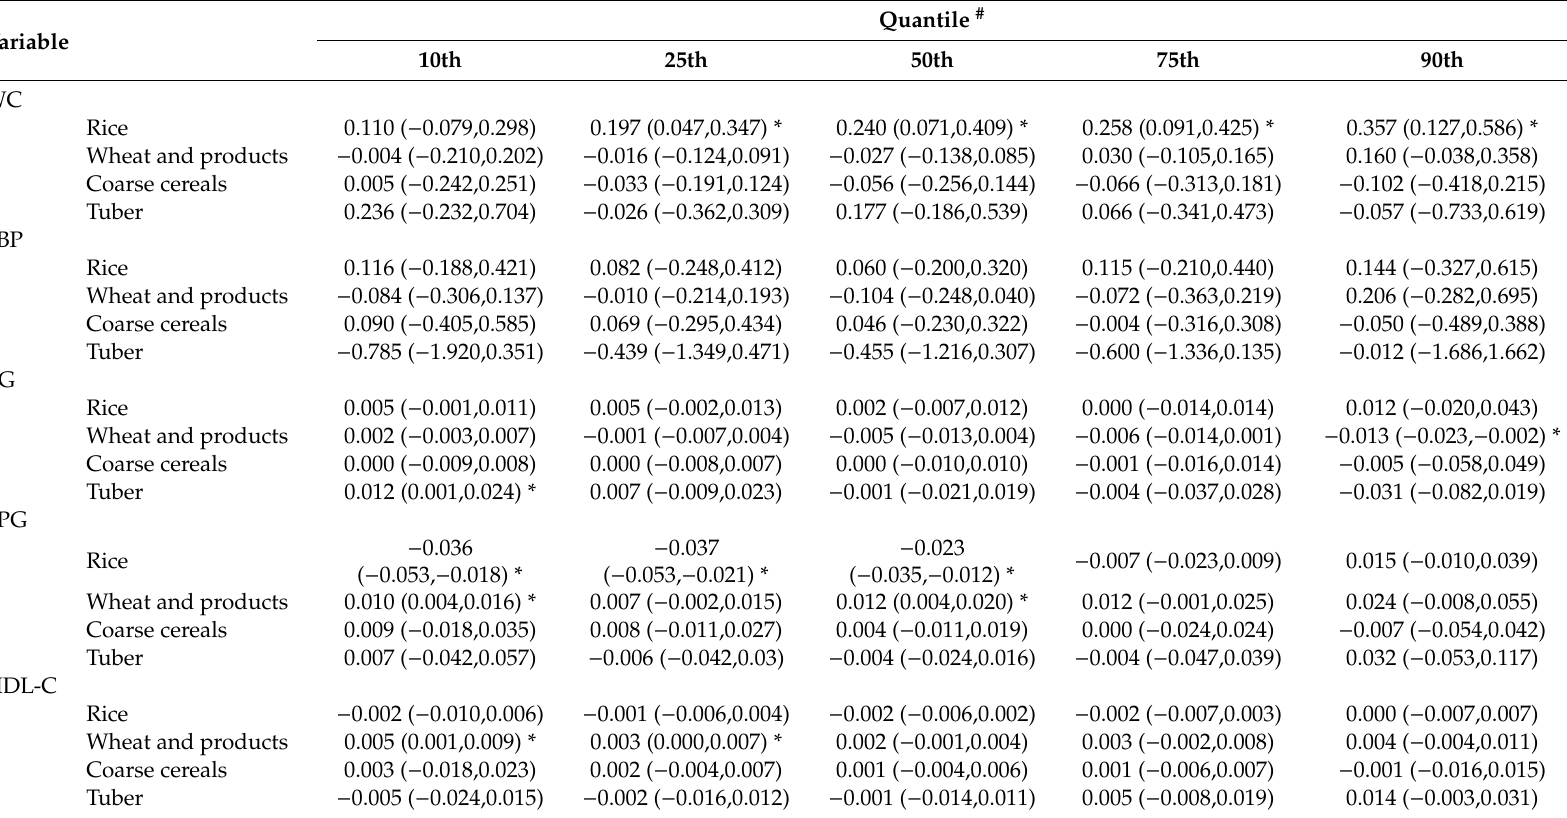
Table 6. Coe ffi cient estimates from a quantile regression on individual components of MetS among northern China by cereal subtype